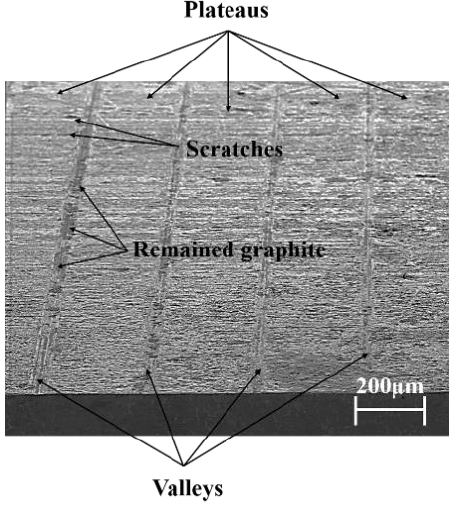
Figure 11. Morphology of skirt plateaus under 10 kN.